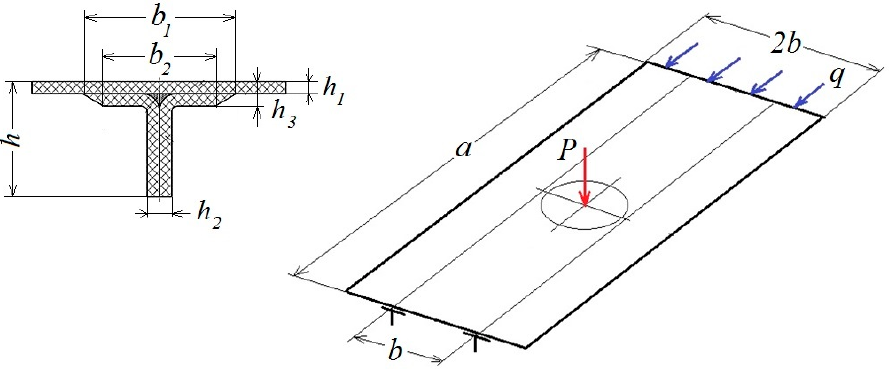
Figure 1. Stiffened panel with impact damage. a —panel length; b —half panel width or the distance between the stringers; h 1 —the composite plating thickness; b 1 , b 2 , h 2 —the stringer geometric parameters; h 3 —the sum of the stringer shelf thickness and the composite plating thickness; h —the sum of stringer height and the composite plating thickness; P —force caused by impactor.